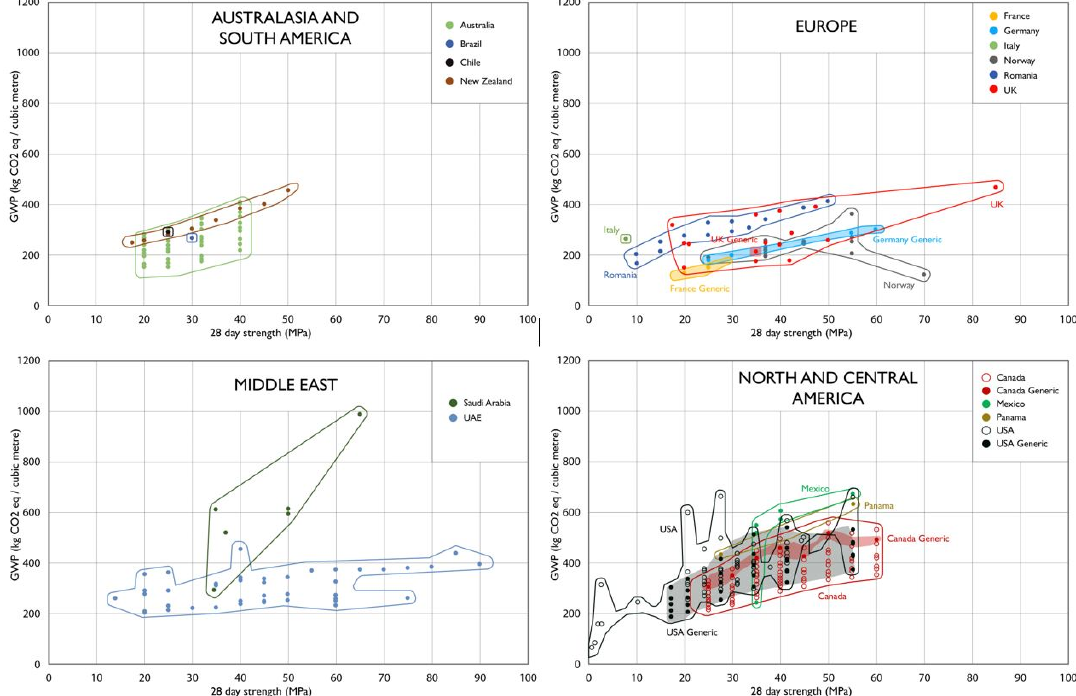
Figure 2. Embodied carbon per m 3 concrete by compressive strength, shown for each country, source